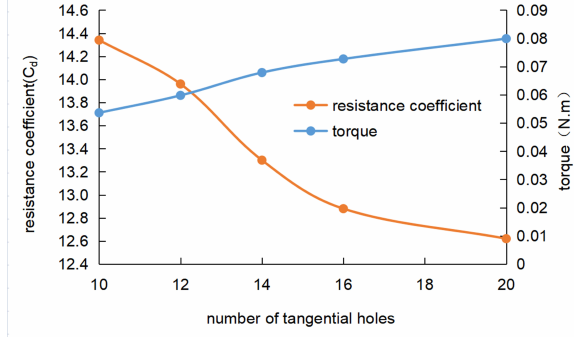
Fig. 14. Variation curve of resistance coefficient and